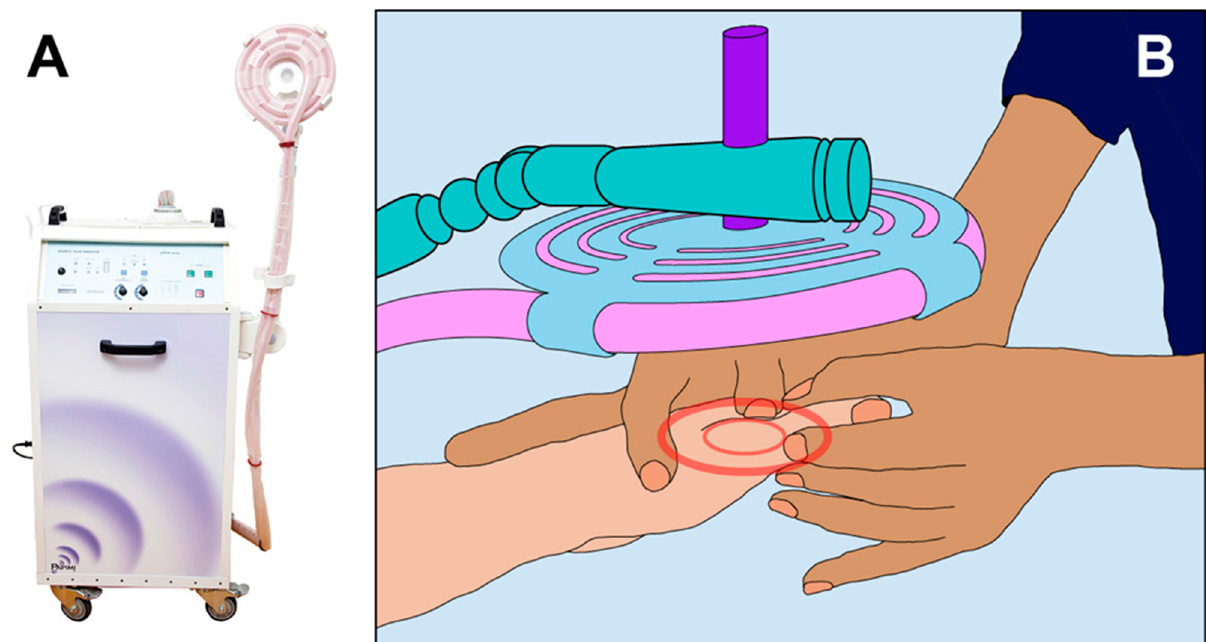
Figure 2. PAPIMI intervention. ( A ) PAPIMI TM device. ( B ) The physiotherapist applied the treatment coil over the referred pain zone and then adjusted the distance between the coil and the skin surface of the patient.